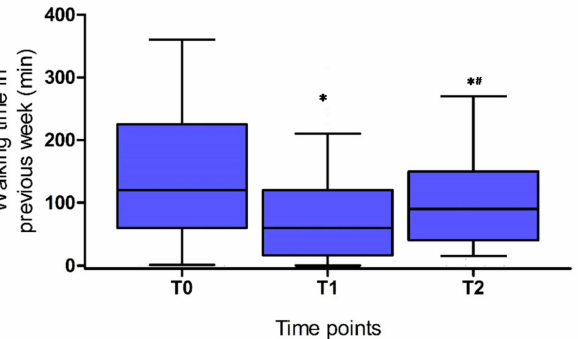
Figure 1. Walking time in previous week pre-COVID-19 (T0), at 3 months (T1) and 6 months (T2) of follow-up; * significant difference vs. pre-COVID-19, p < 0.05; # : significant difference vs. 3 months, p < 0.05. Data presented as median, IQR and